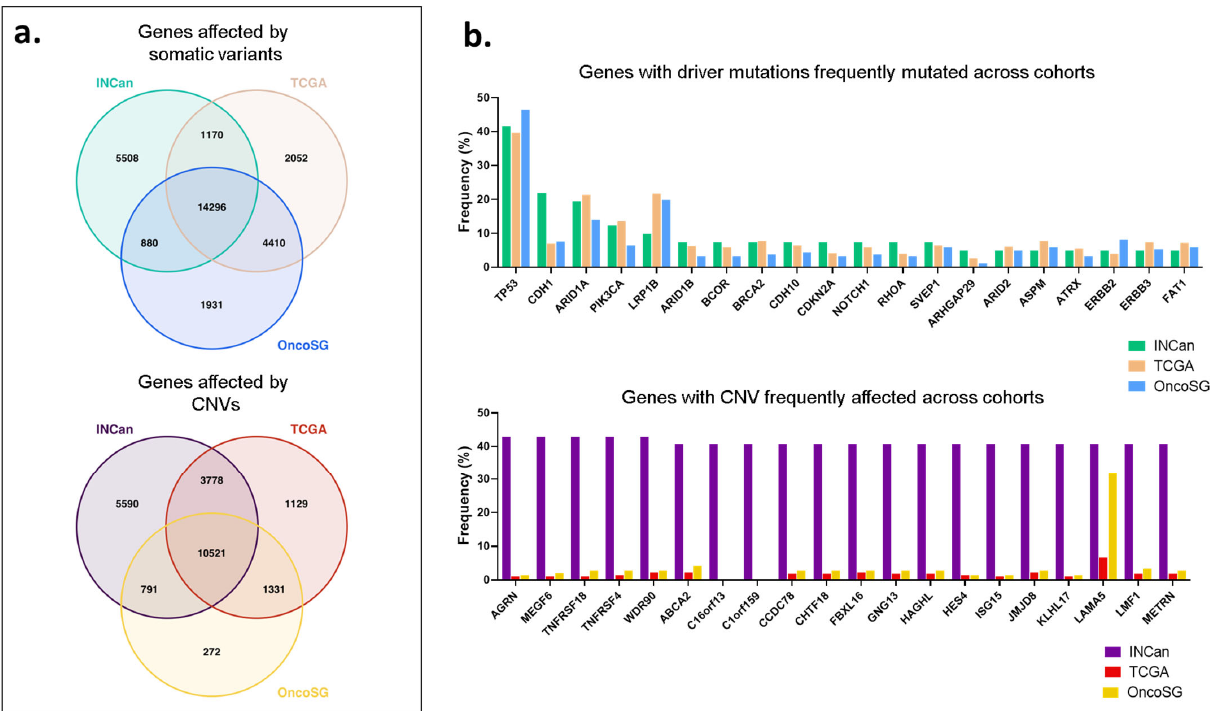
Figure 6. Genes affected by somatic variants and copy number variations in patients with gastric adenocarcinoma among three different cohorts. ( a ) Venn diagram depicting the number of